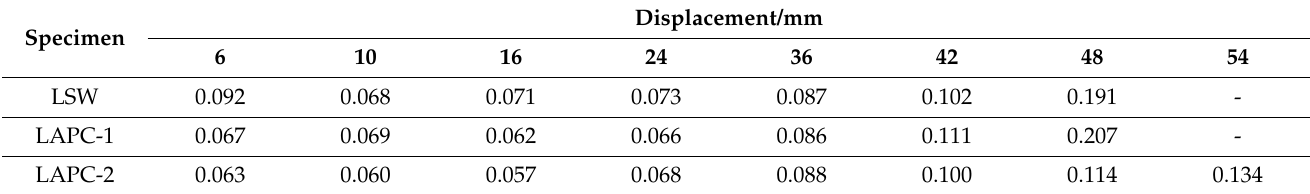
Table 4. The equivalent viscous damping coefficient of each specimen at different stages.